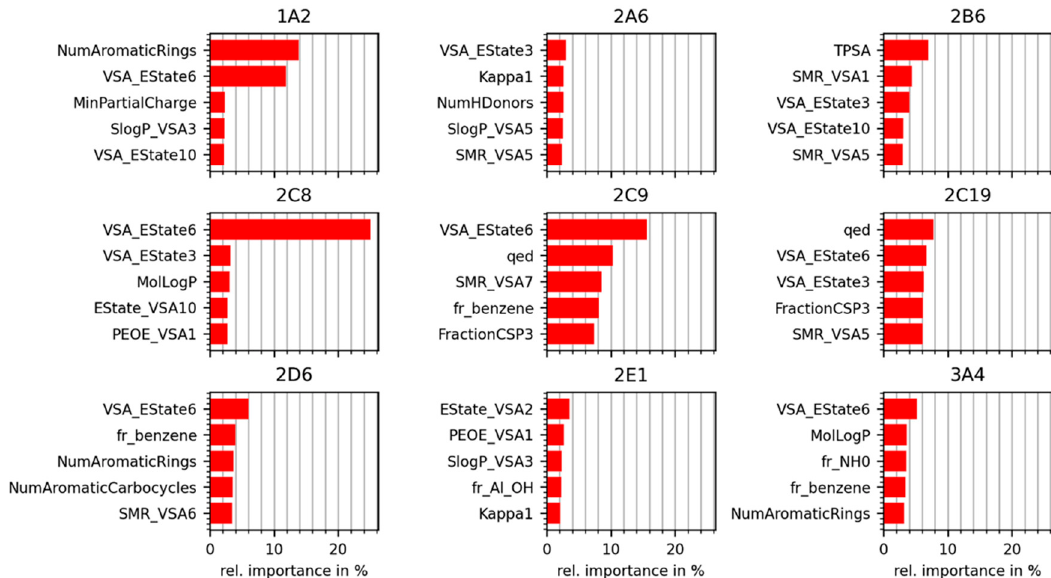
Figure 7. Relative feature importances (calculated as Gini importances) of the five most relevant RDKit 2D descriptors identified during 5-fold CV by the best RF classifiers (by MCC) trained on RDKit 2D descriptors. A detailed description of the descriptors is provided in Table S2.